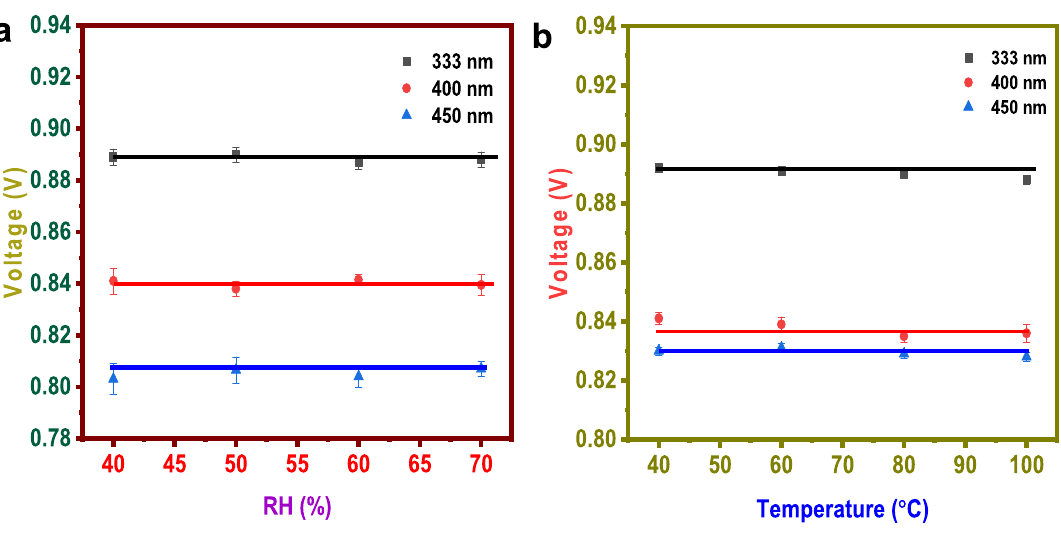
Figure 7. ( a ) Humidity effect, ( b ) temperature